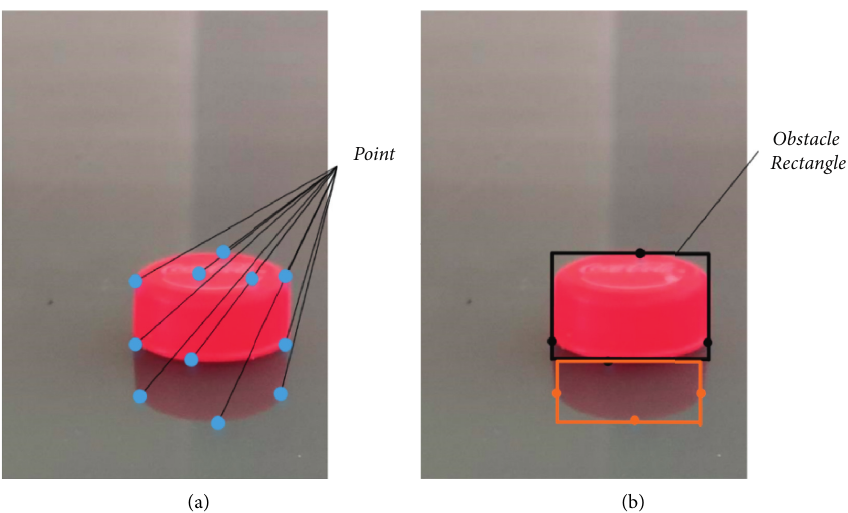
Figure 13: The first image. (a) The feature points. (b) Construction of the obstacle rectangle by the feature points.